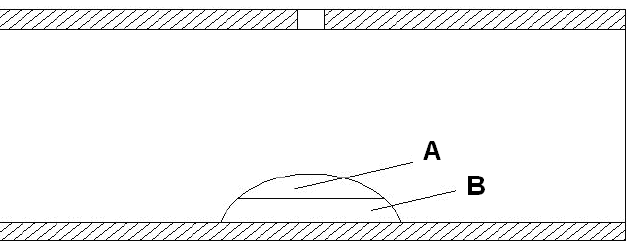
Figure 1. Schematic of sample thick layer the in graphite furnace: contacting (top) zone (A) and non-contacting (bottom) zone (B) with the atomizer